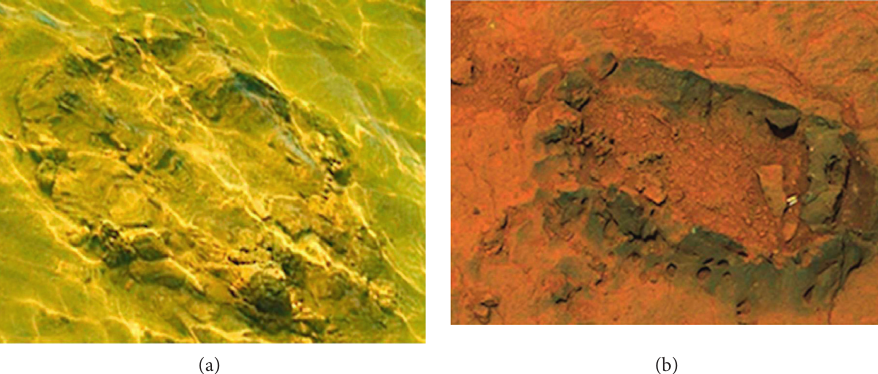
Figure 2: (a) The remains of a Lake Thetis underwater stromatolite. Photo credit: government of Western Australia department of mines and petroleum. (b) Sol 308 water pathways leading down and curving around a Martian specimen resembling a Lake Thetis stromatolite. Reproduced with permission from [38].